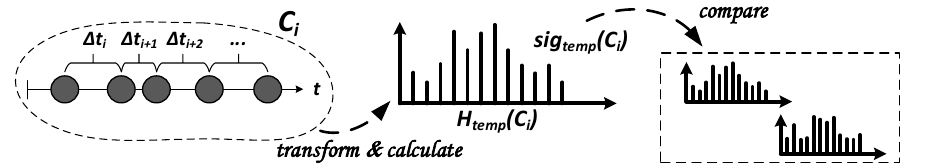
Figure 6. The generation and comparison process of the signature sig temp